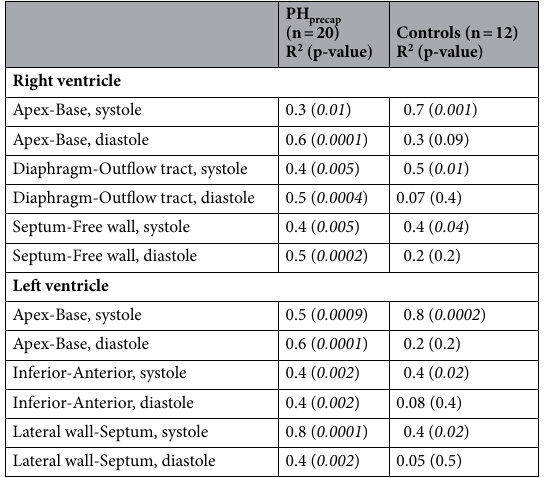
Table 3. Hemodynamic forces and stroke volume. Significant values are in [italics]. Association between systolic root mean square hemodynamic forces (HDF) and stroke volume in patients with PH precap and healthy controls. For R 2 , the independent variable was set as stroke volume, and the dependent variable was set as hemodynamic